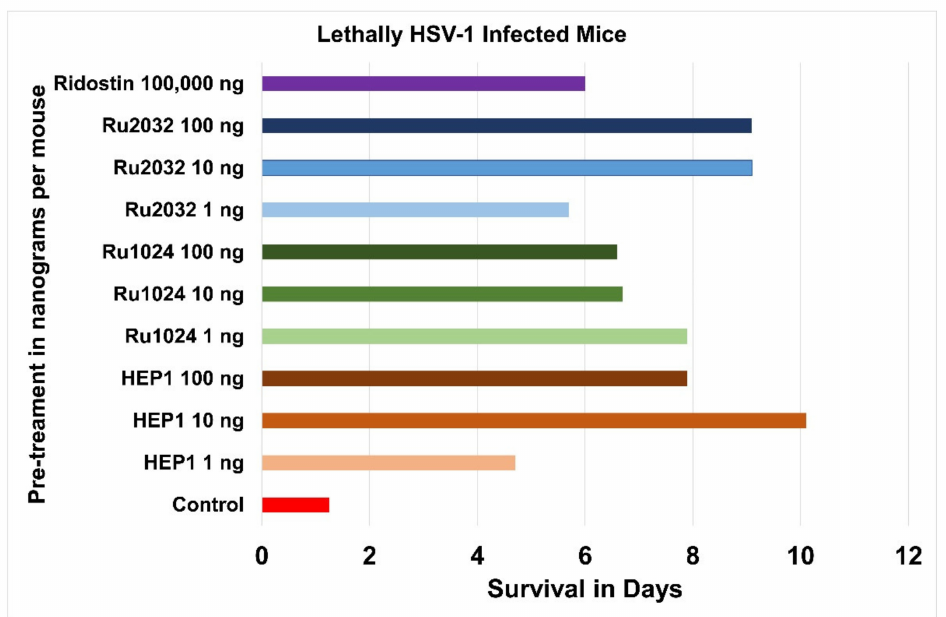
Figure 14. Adjuvant activity of ezrin hep-receptor peptides at three different concentrations (1 or 10 or 100 ng per mouse) conferring protection in the mouse lethal herpes virus infection model measured by the increase in survival in days. Red bar: no adjuvant (negative control mice), purple bar: Ridostin adjuvant (positive control mice) and hundred-fold concentration ranges of synthetic peptides that are ezrin hep-receptor mimics; blue-tones Ru2032 KEELMLRLQDYEE, green-tones